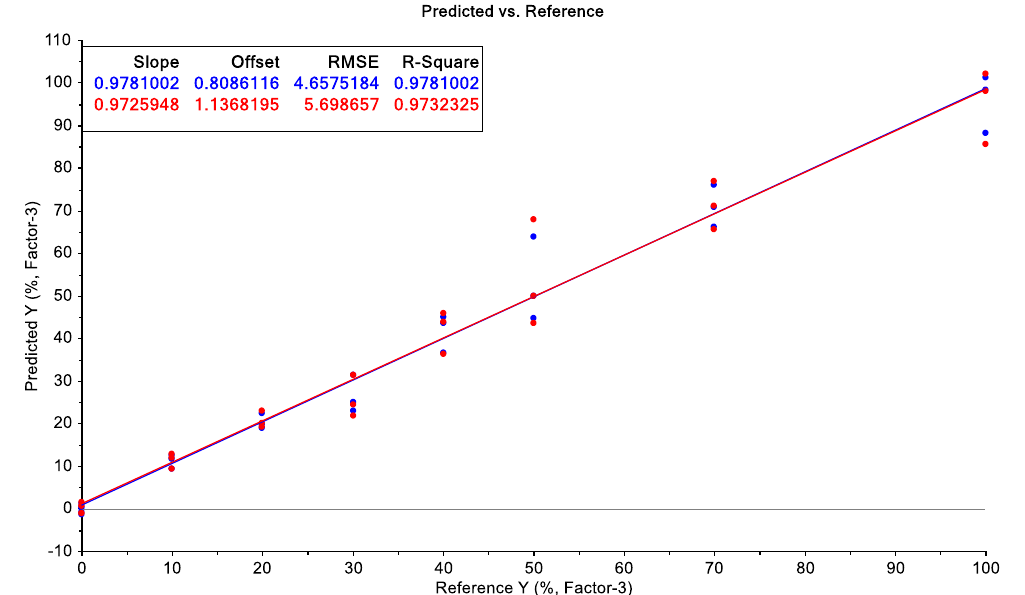
Figure 2. PLSR model of cocoa shell calibration series 3 (0 – 100% cocoa shell).